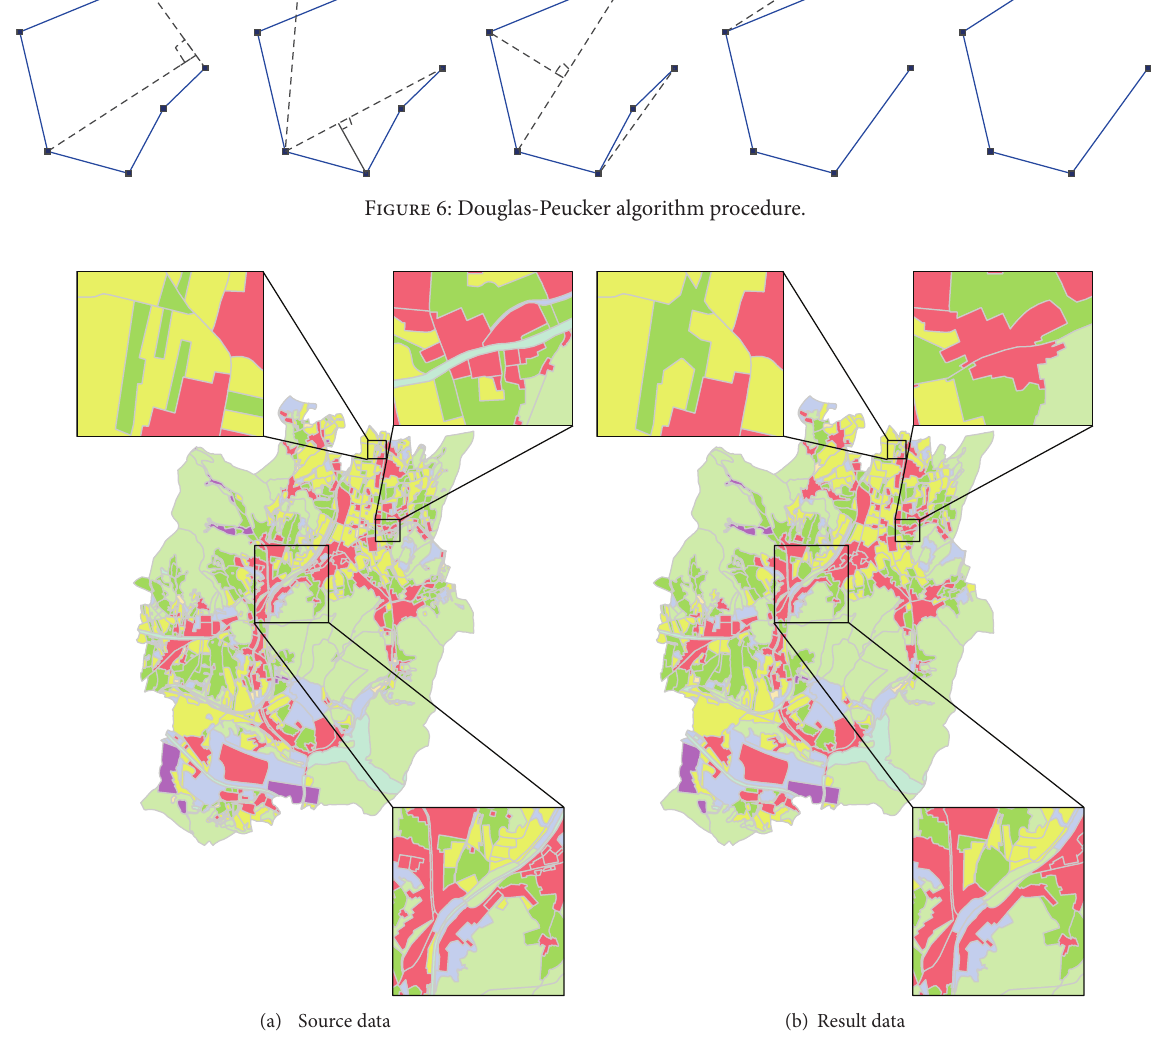
Figure 7: Comparison of